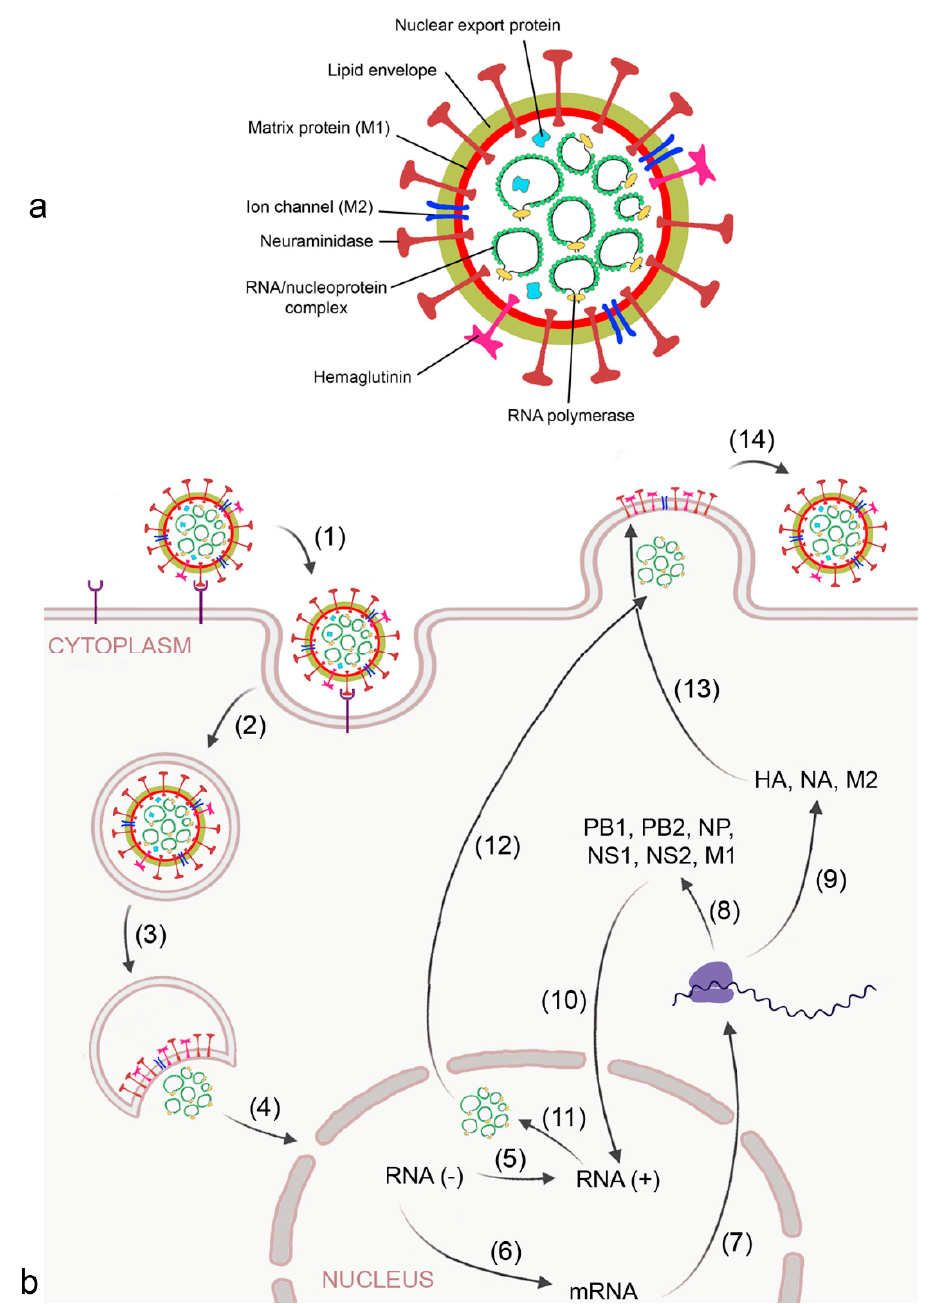
Figure 2. Morphology ( a ) and replication cycle ( b ) of influenza A virus. Replication includes the following steps: (1) binding of the virus to sialic acid-containing surface receptors by viral hemagglutinin (HA); (2) endocytotic uptake; (3) release of the RNA/ nucleoprotein complex; (4) transport of the ribonucleoproteins into the nucleus; (5) replication of the RNA strand by viral RNA polymerase into the complimentary + strand; (6) transcription of the RNA strand into mRNA by viral RNA polymerase; (7) export of mRNA from the nucleus; (8) synthesis of viral RNA polymerase subunits polymerase basic (PB) 1 and 2, matrix protein 1 (MP1), nucleoprotein (NP), and non-structural (NS)1 and 2 for reconstruction of the RNA/nucleoprotein complex; (9) synthesis of HA, neuraminidase (NA), and matrix protein 2 (M2) at the host ribosome and endoplasmic reticulum;(10) transport of PB1, PB2, M1, NP, NS1, NS2 into the nucleus; (11) formation of the nucleoprotein complex; (12) trans- port of the nucleoprotein complex out of the nucleus by viral nuclear export protein; (13) integration of HA, NA, and M2 into the budding plasma membrane, and (14) release of the virion by NA